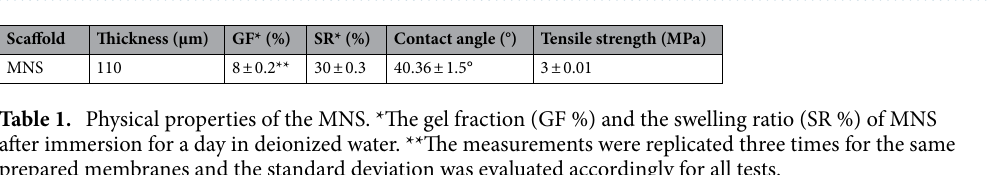
Figure 1. ( a ) XPS survey spectrum of prGO with ( b ) typical high-resolution XPS spectra of C1s and ( c ) typical high-resolution XPS spectra of O1s, ( d ) Raman spectrum of prGO, and ( e ) XRD spectra, ( f ) FTIR spectrum, ( g ) Nitrogen sorption isotherm with inset plot represent the BJH plot of MNS pores diameter, and ( h ) TEM image of MNS electrospun nanofiber scaffold.